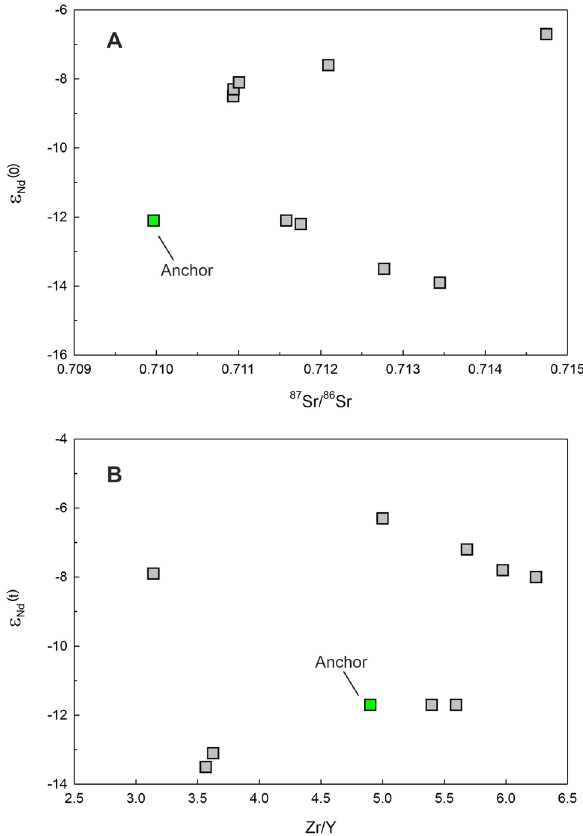
Figure 10. ( A ) ε Nd (0) versus 87 Sr/ 86 Sr and (B) ε Nd (t = 66 Ma) versus Zr/Y for the Chilika Anchor rock